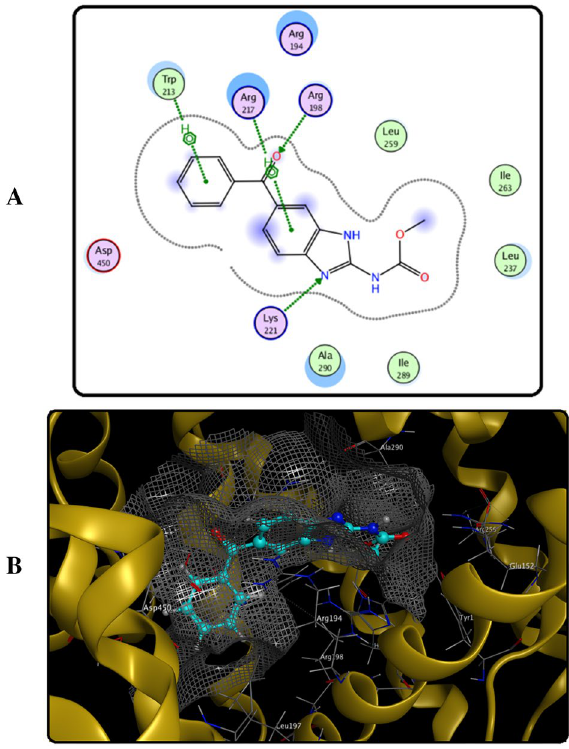
Figure 12. ( A ) Diagram for the amino acid residues incorporated in MBZ-BSA interaction within the binding pocket of BSA site 1, ( B ) 3D structure of the binding interaction between